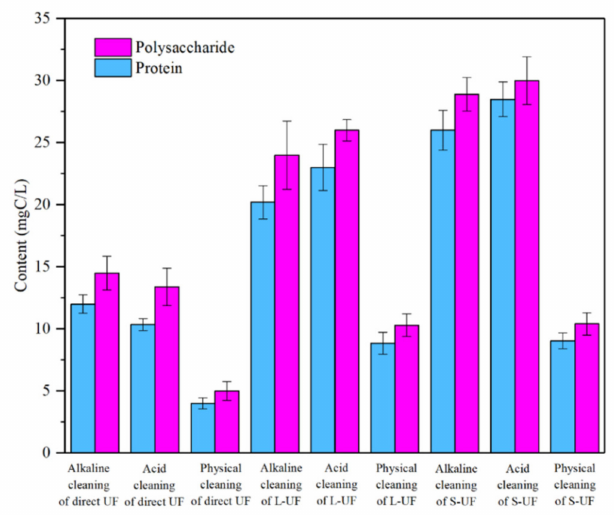
Figure 6. EPS content in membrane elution.